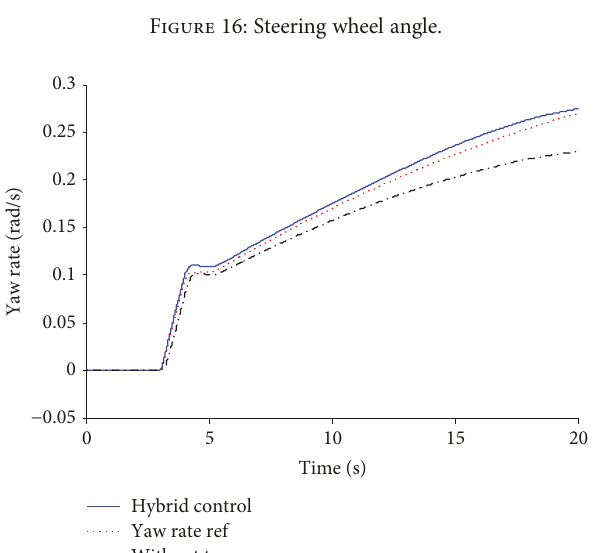
Figure 16: Steering wheel angle.